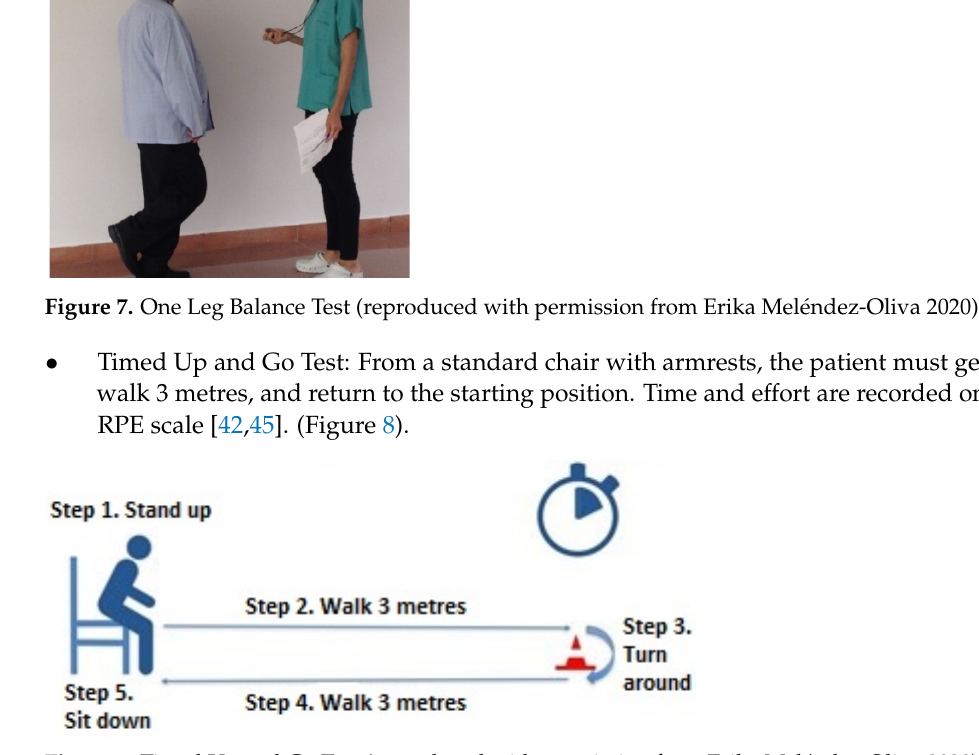
Figure 8. Timed Up and Go Test (reproduced with permission from Erika Meléndez-Oliva 2020) [43].